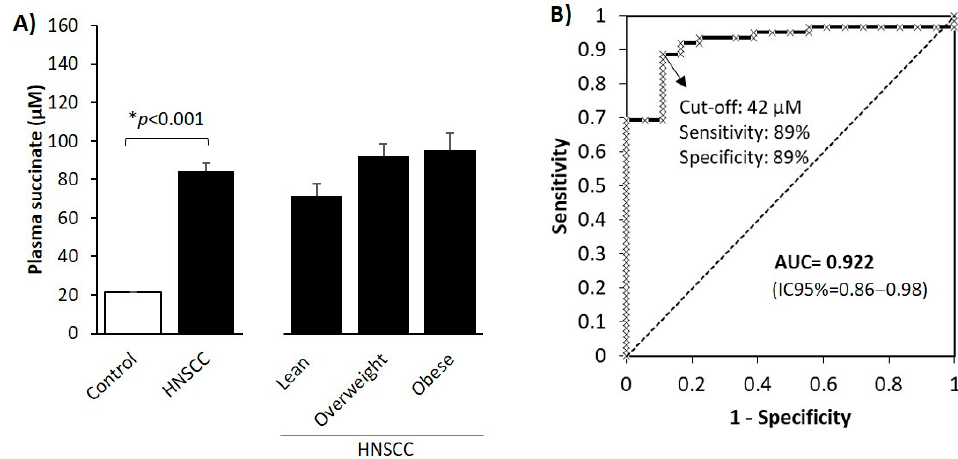
Figure 1. Succinate as a diagnostic marker in HNSCC . ( A ) Circulating succinate in patients with HNSCC and control subjects. Patients were also stratified according to their body mass index (BMI). Results are expressed as mean (SEM). Differences between groups were calculated using Student’s t -test for independent samples (left panel) or analysis of variance (ANOVA, right panel). *, Differences were considered statistically significant at p < 0.05. ( B ) Receiver operating characteristic curve for succinate levels. AUC: area under the curve.